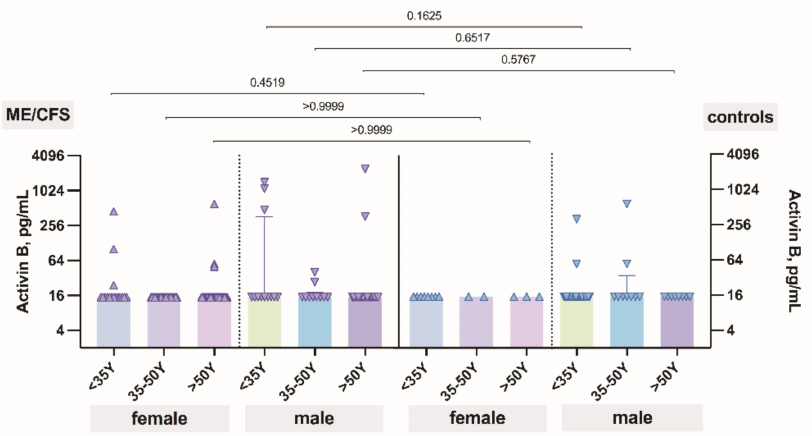
Figure 3. The levels of activin B in patients with ME/CFS and controls plotted against